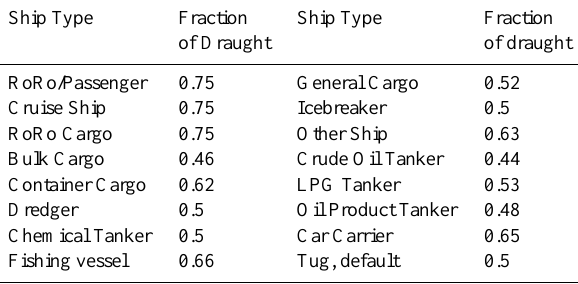
Table A1. Fraction of draught values for different ship types to be used in estimation of propeller diameter unless it is specifically known or can be estimated with methods described in the